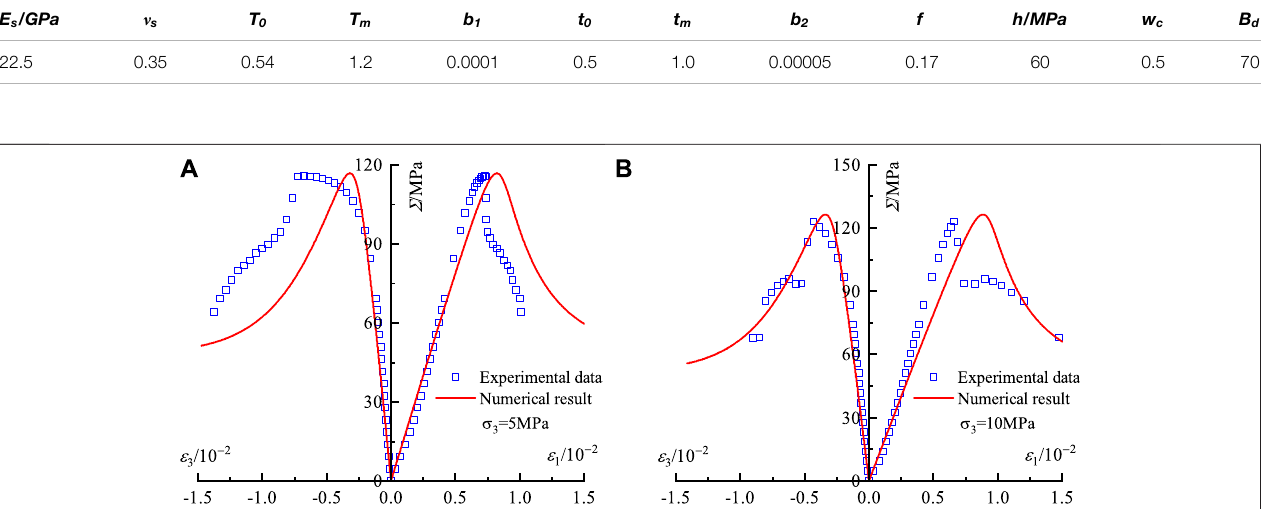
Frontiers in Physics |